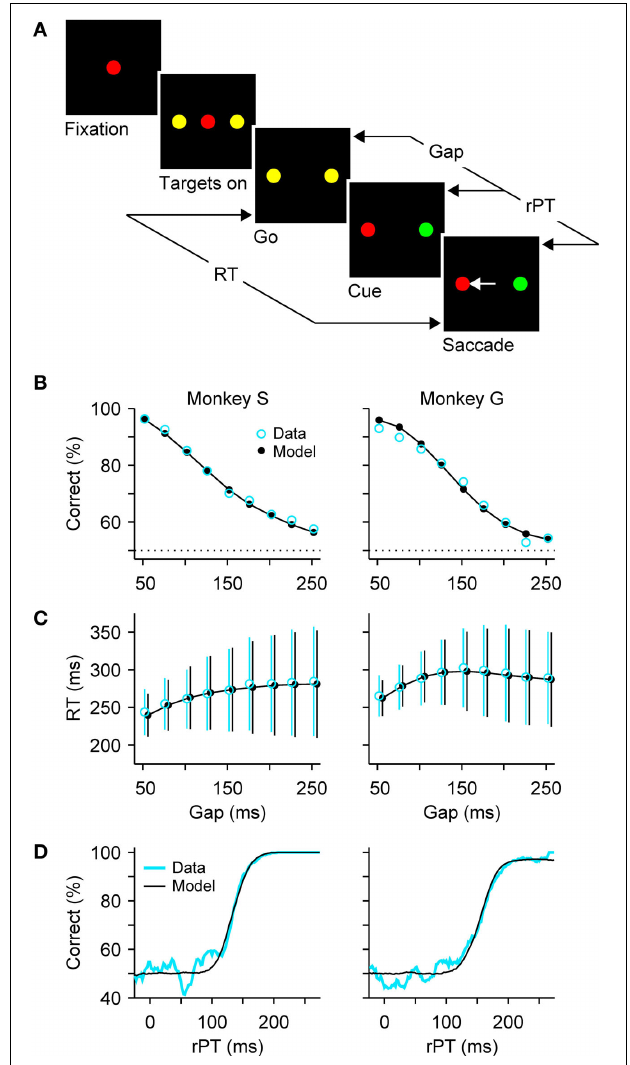
FIGURE 1 | Dissociating perceptual and motor performance in the compelled-saccade task. (A) Sequence of events in the task. The subject is required to make a saccade when the fixation point disappears (go). If the chosentargetmatchesthecolorofthefixationpoint(red,inthisexample),the choice is correct and a reward is obtained. The go instruction is given first, before the relevant sensory information is revealed (cue). The gap (50—250ms) is the time interval between the go and the cue. The rPT is the amount of time during which the color information can potentially inform the saccadic choice. (B) Percentage of correct responses as a function of gap, or psychometric curve. (C) Mean RT ( ± 1 SD) as a function of gap, or chronometric curve. Both correct and incorrect trials are included. ( D ) Percentage of correct responses as a function of rPT (equal to RT − gap), or tachometric curve. In (B–D) , blue and black lines/symbols correspond to psychophysical and simulation results, respectively. See Shankar et al. (2011) for details about the experimental data and modeling